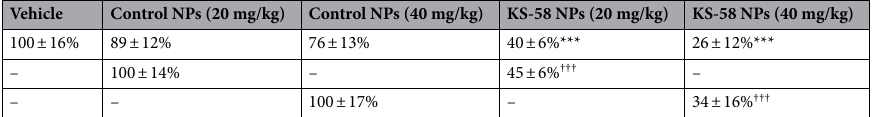
Table 1. CT26 tumor growth rate in vivo. Growth rate (%) was calculated based on the tumor volume of the vehicle group at day 17 as 100% and expressed as the mean ± SD (n = 4, *** p < 0.001 vs. Vehicle group